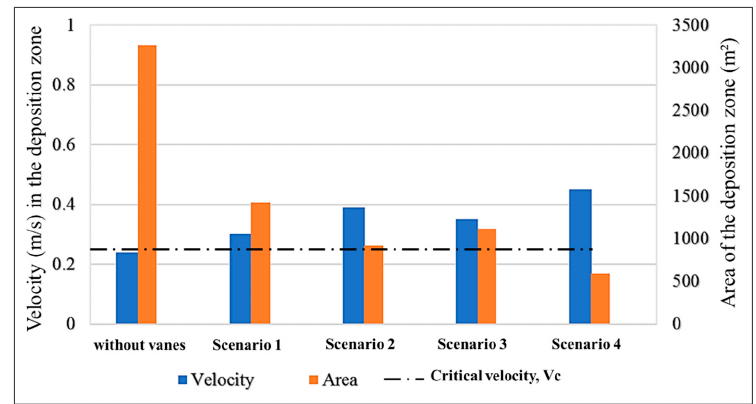
Figure 15. Impact of using vanes on velocity and reduction area in the deposition zone for the studied configurations. studied